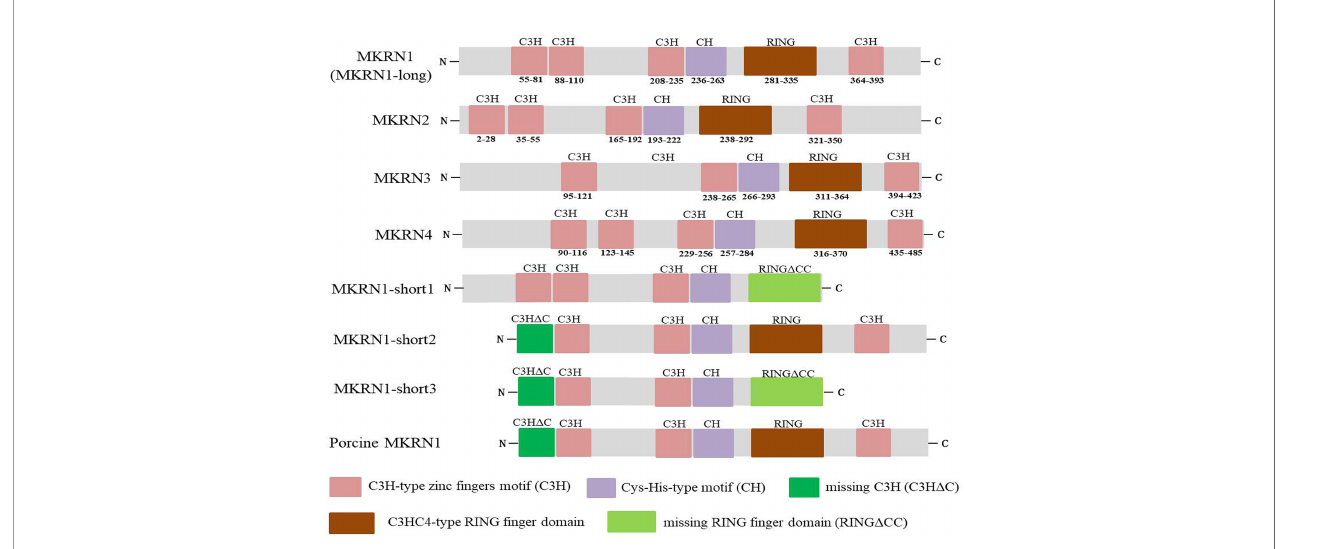
FIGURE 2 | Functional domains of human MKRN1 (MKRN1-long), MKRN2, MKRN3 and MKRN4, the transcript variants of human MKRN1 (MKRN1-short1, MKRN1-short2, MKRN1-short3) and porcine MKRN1. The makorins contain several C3H zinc fi nger domains (pink), a Cys-His (CH) motif (purple), a C3HC4 RING domain (red), missing C3H motif (C3H D C) (green) and RING fi nger domain (RING D CC)